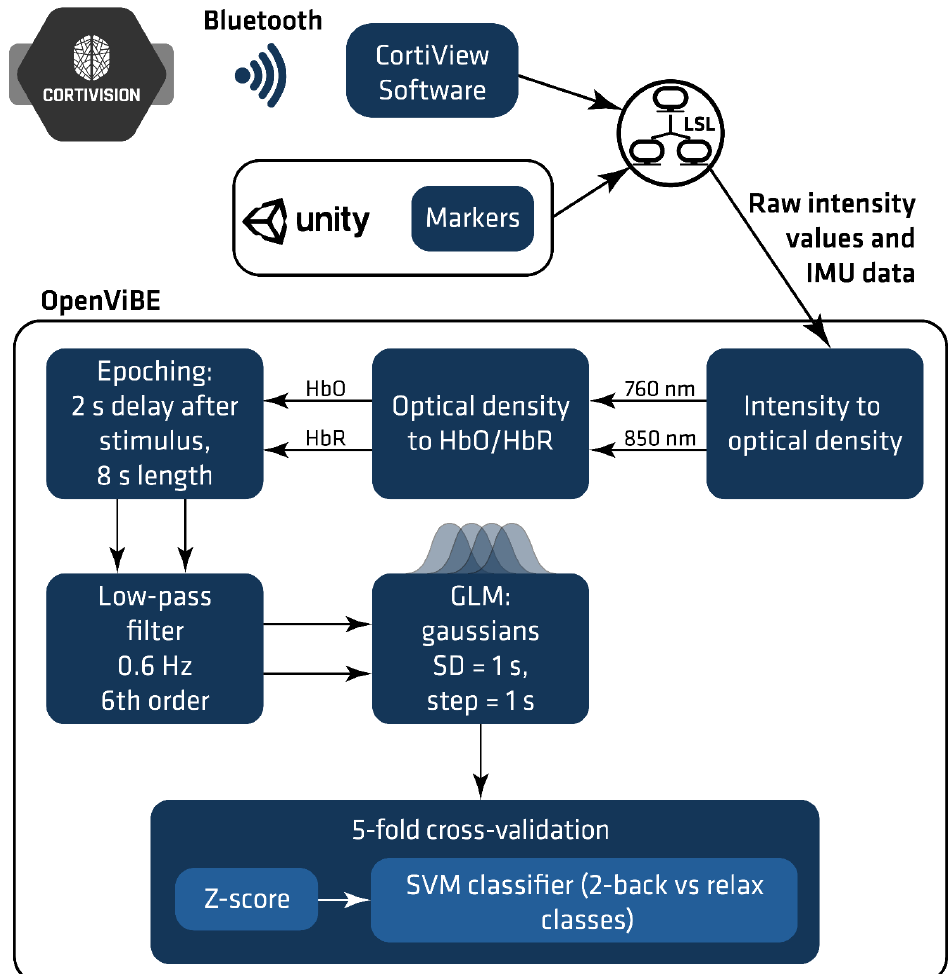
Figure 4. Signal processing pipeline in OpenViBE environment for data from calibration and online session.